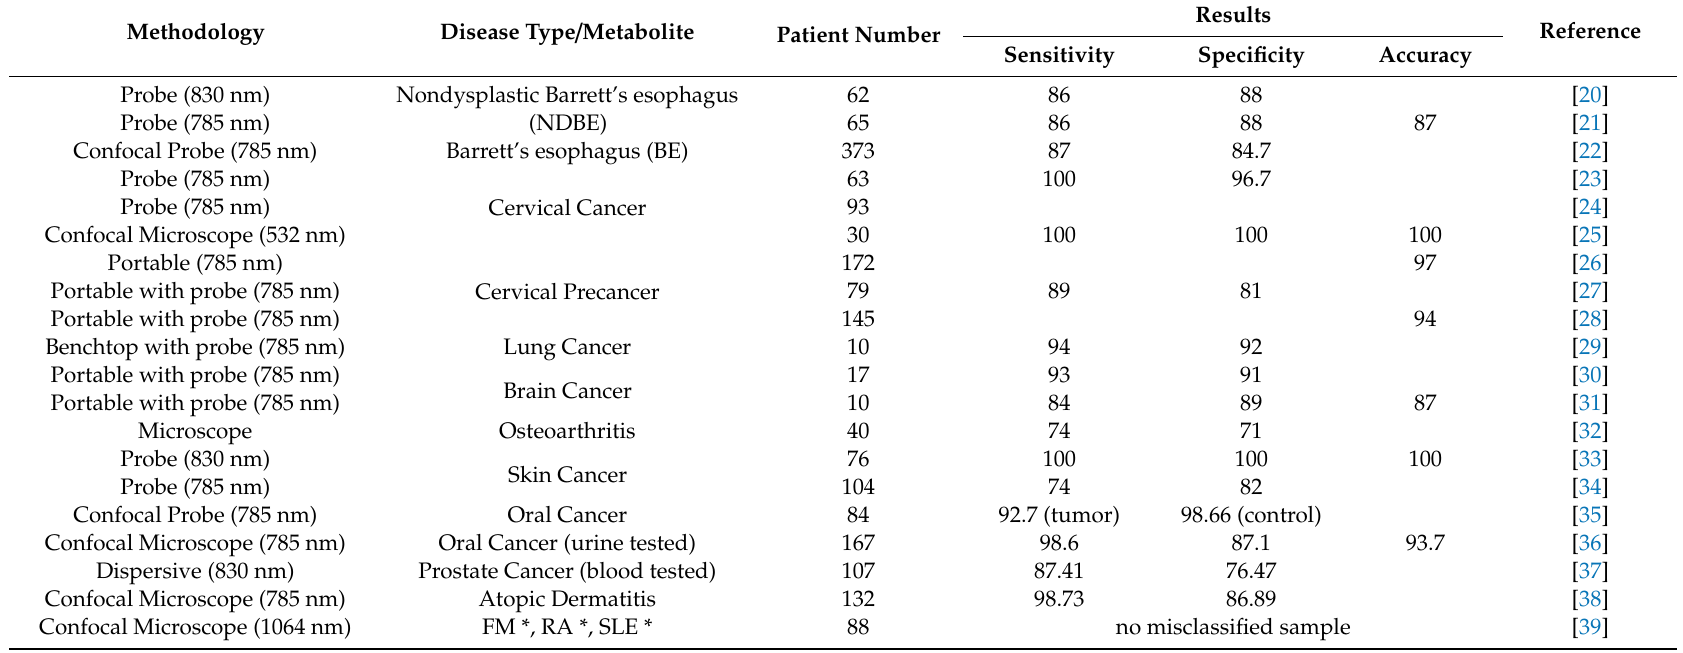
Table 1. Overview of clinical studies performed by using Raman spectroscopy as a diagnosis tool in vivo in humans.